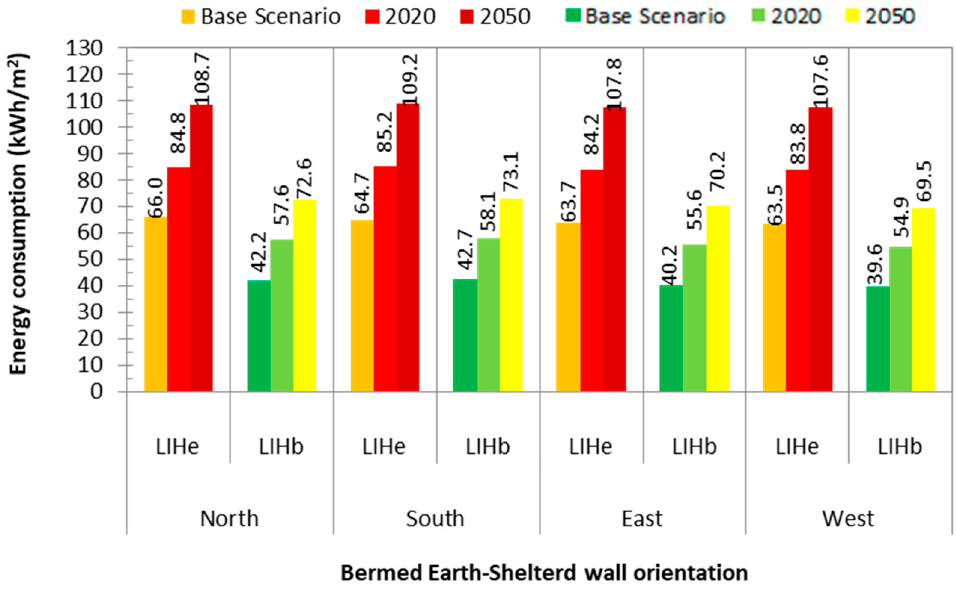
Figure 5. Annual energy consumption of the bedrooms .